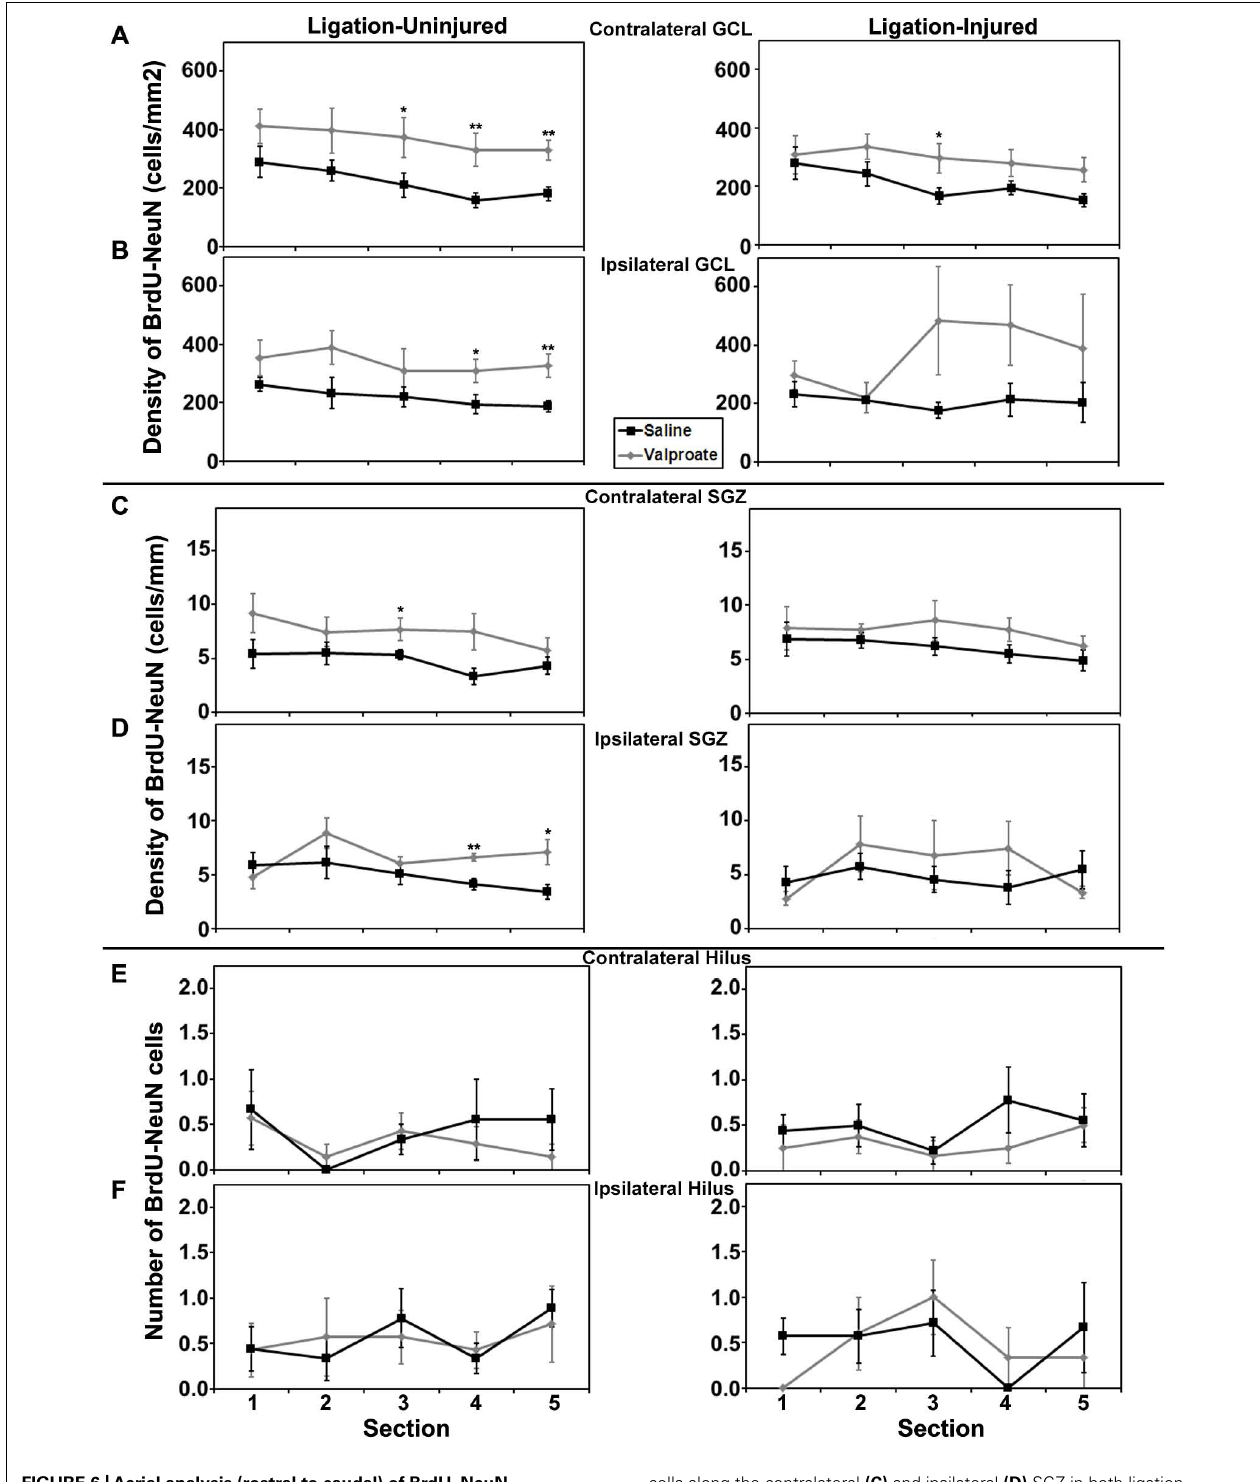
FIGURE 6 |Aerial analysis (rostral to caudal) of BrdU–NeuN density (A–D) or counts (E,F) in mice treated with valproate or saline in Protocol 2. (A,B) Average densities of BrdU + /NeuN + within the contralateral (A) and ipsilateral (B) GCL in both ligation- uninjured (left panel) and ligation-injured (right panel) mice treated with valproate or saline. (C,D) Average densities of BrdU + /NeuN +